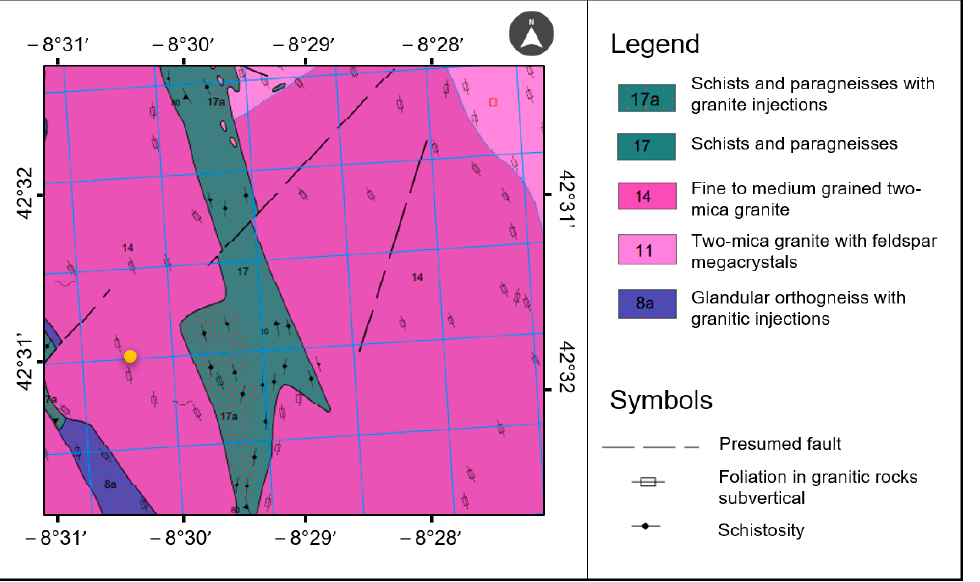
Figure 2. Geological characterization of the area under study. Coordinates are presented as latitude and longitude.